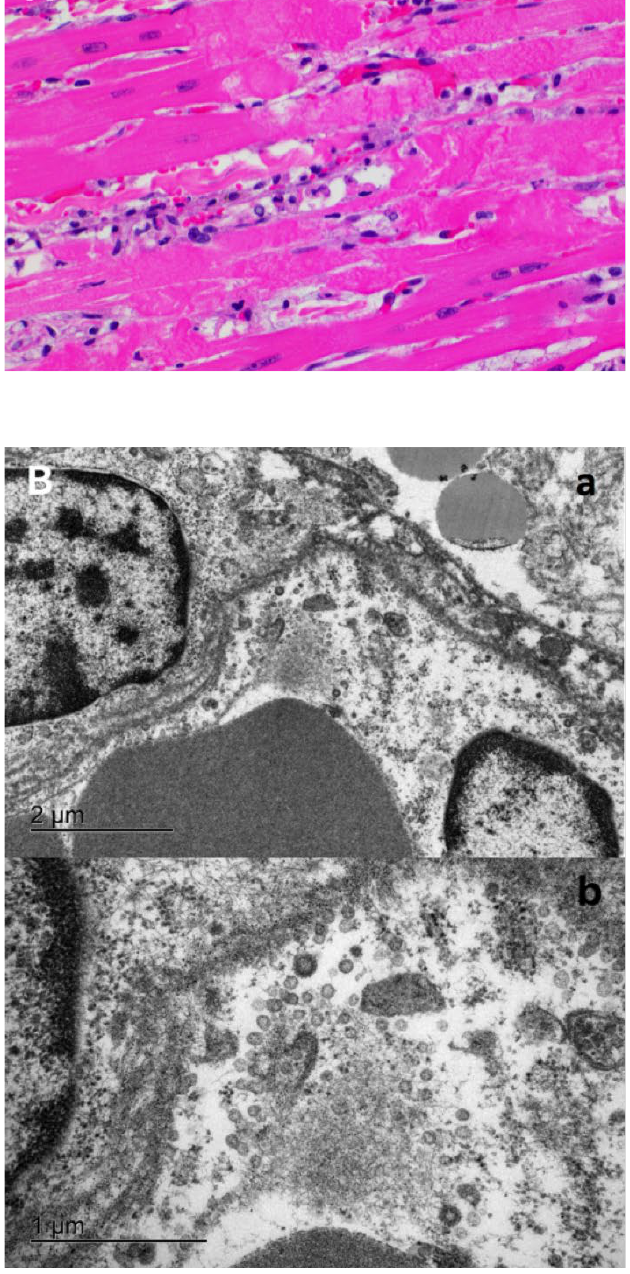
Figure 4. Morphologic changes and viral localization in the heart of the SARS-CoV-2 infected cat. ( A ) Myocardial degeneration and necrosis. Cardiomyocytes with hypereosinophilic sarcoplasm with hypercontraction bands and loss of striations. Small numbers of neutrophils and macrophages in the myocardial interstitium. Hematoxylin and eosin. 40× magnification. ( B ) Electron microscopy of the ventricular myocardium. A blood vessel containing portions of two erythrocytes (lower left) and lined by two endothelial cells, each with a partial profile of the nucleus. Multiple coronavirus-like particles are within endoplasmic reticulum cisternae or are adjacent to free ribosomes and fragmented cytosolic debris (autolysis) (panel a). Bar = 2 µ m. Panel b—Higher magnification of panel a. Virus particles are round with an outer double membrane and a core that contains variably distinct electron dense dots representing cross sections of the nucleocapsid. Bar = 1 µ